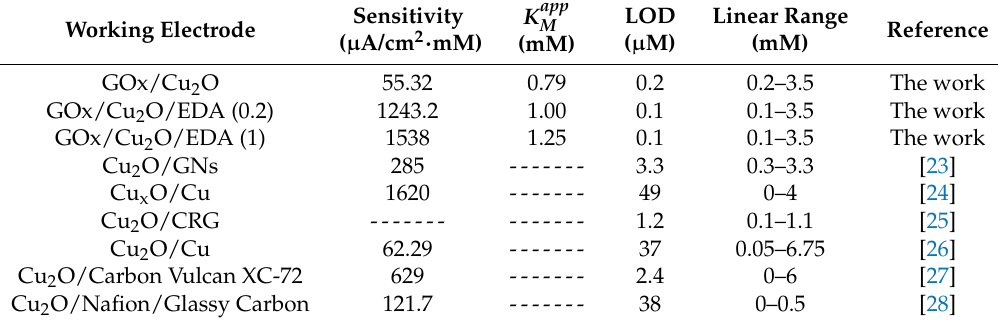
Table 2. Comparison of glucose biosensor characteristics with different Cu 2 O nanostructures in literature.